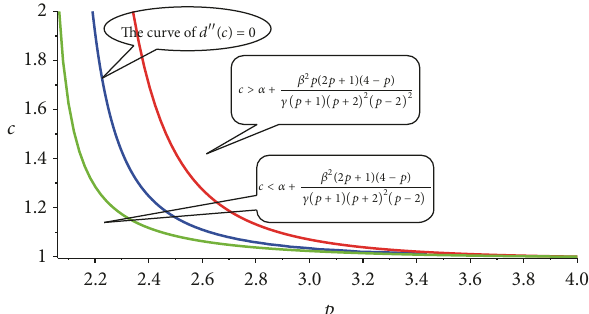
Figure 3: The stability region of the solitary wave solution (6) when 𝛼 = 1 , 𝛽 = 1, 𝛾 = 3,2 < 𝑝 < 4 .